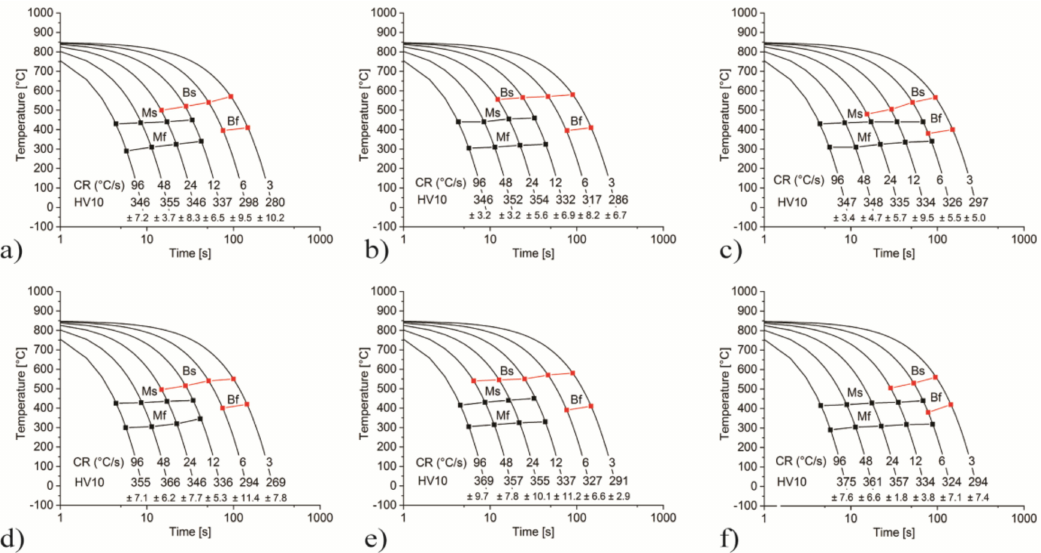
Figure 3. CCT diagrams of investigated steels, ( a , d ) DQ, ( b , e ) DQ + 0.02Nb, ( c , f ) DQ + 0.05 Nb. Upper row: no deformation; lower row: 3 × 0.2 prior